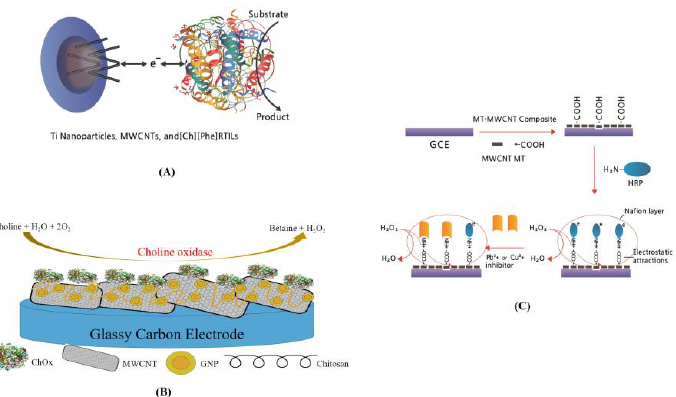
Figure 5. CNT-based biosensor with enzyme as a bioreceptor. ( A ) Scheme of SWCNT-based nano- biosensor using GC screen-printed electrode (SPE) was manufactured modified with MWCNTs, TiO 2 nanoparticles, and newly produced ionic liquids (RTILs) for glucose detection [72]; ( B ) Scheme of amperometric biosensor using ChOx/(GNP)4/MWCNT/GCE for choline determination [81]; ( C ) Stepwise amperometric biosensor fabrication process and immobilized horseradish peroxidase inhibition in metal ion solution